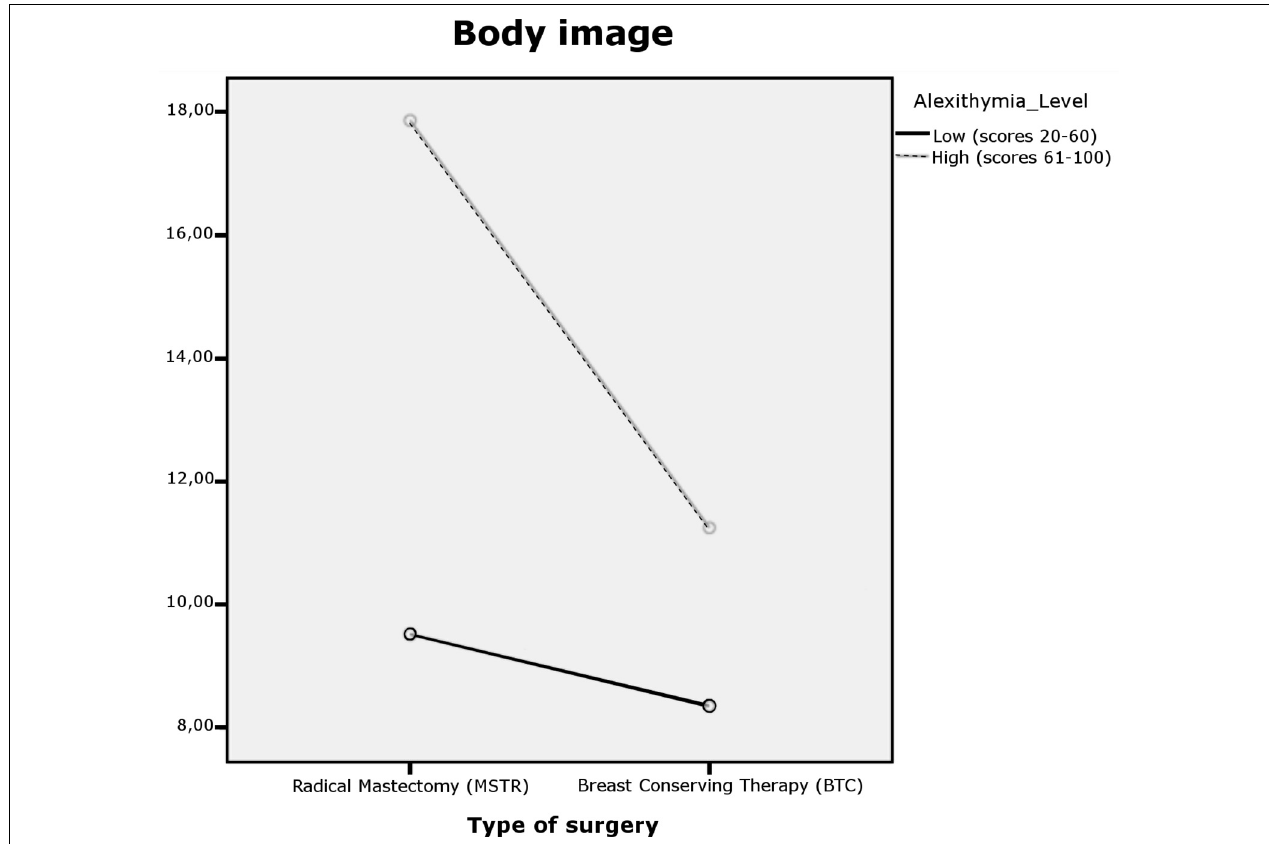
FIGURE 1 | Dual interaction graph for body